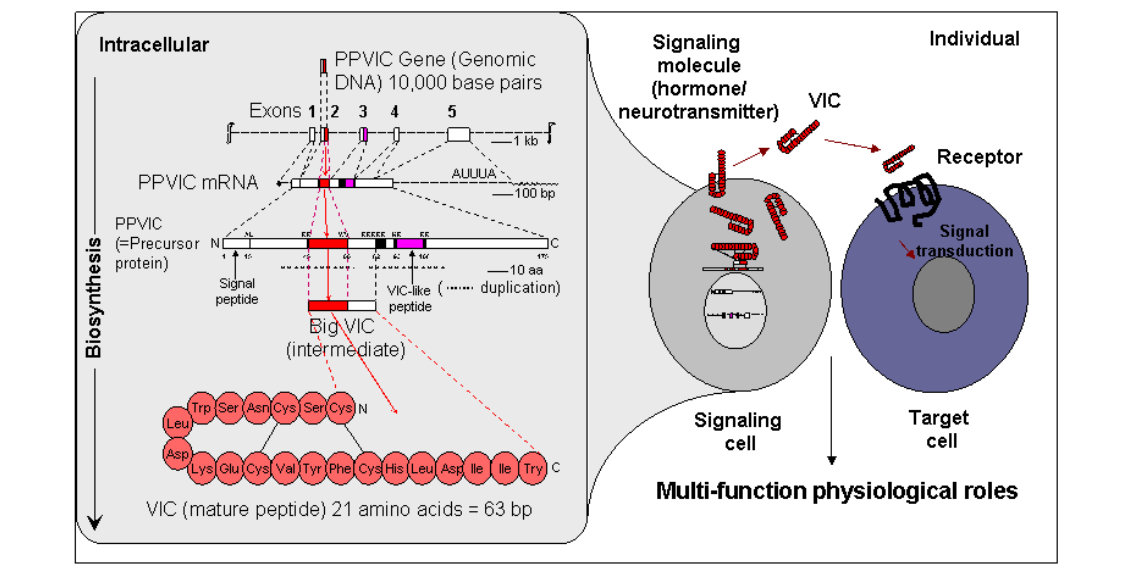
FIGURE 2. Biosynthetic pathway and biosignaling system of ET-2/VIC. Physiologically active mature peptide VIC/ET-2 is processed from the precursor protein, prepro ET-2/VIC, in 2 steps: from prepro-form to big intermediate form by an endopeptidase and from big form to mature peptide by a converting enzyme. The VIC/ET-2 gene, composed of 5 exons, is localized on chromosome 4 in mouse[74], chromosome 5 in rat[75], and chromosome 1 in human[4,76]. A nucleotide region for the mature peptide is located in the second exon. Alternative splicings are reported[77,78]. Multifunction physiological roles such as embryonic development and reproduction, in addition to its effects on the gastrointestinal system, are exhibited via receptors in a paracrine (right side), autocrine, or intracrine